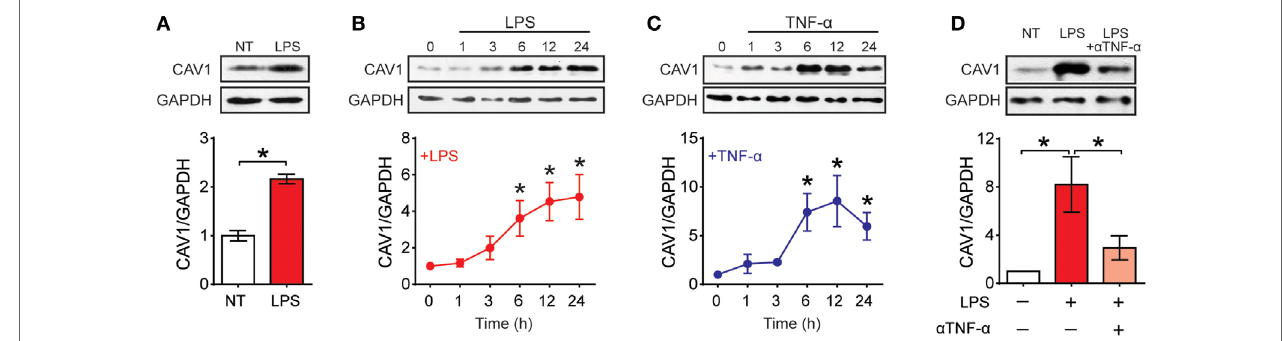
FigUre 1 | Caveolin-1 (CAV1) is expressed in dendritic cells (DCs) and upregulated upon maturation. CAV1 expression in DCs was assessed by Western blotting. GAPDH and actin were used as loading controls. CAV1 protein expression was quantified by densitometry analysis and standardized to loading control. Values normalized to untreated controls (NT) are shown. (a) Spleen DCs purified from wild-type mice were treated with LPS (100 ng/ml) for 6 h. (B,c) Bone marrow-derived DCs (BM-DCs) were stimulated with LPS (100 ng/ml) or TNF- α (20 ng/ml) for 0, 1, 3, 6, 12, or 24 h. (D) BM-DCs were treated with LPS (100 ng/ml) alone or in combination with a TNF- α blocking antibody (5 µg/ml) for 24 h. Values are presented as the mean ± SEM. * p < 0.05; n = 3 independent